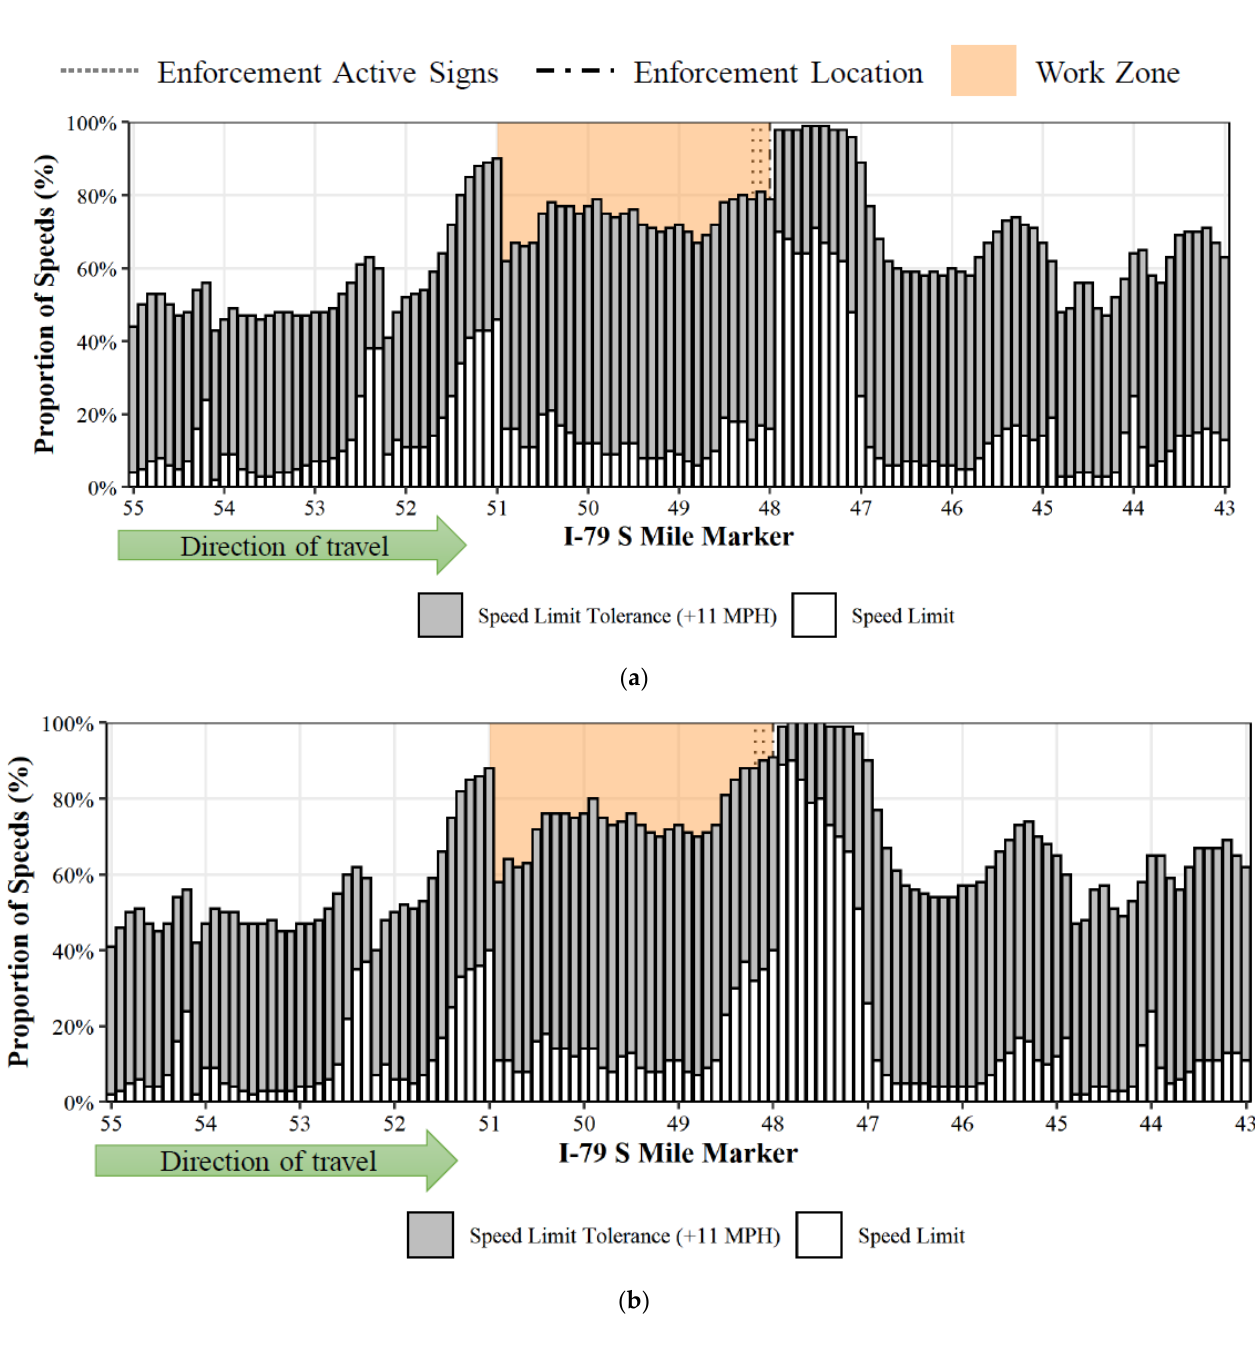
Figure 7. Compliance with speed limit and within speed limit tolerance, with and without enforce- ment. ( a ) Enforcement absent. ( b ) Enforcement Present.